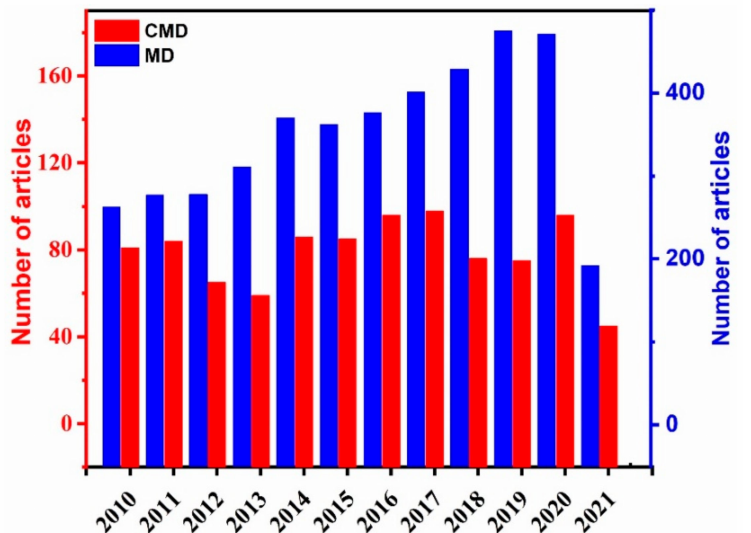
Figure 1. The chart displays the publications on catalytic methane decomposition (CMD) and methane decomposition (MD). The data were collected from Scopus using the keywords “catalytic methane decomposition” and “methane decomposition” between 2010 and